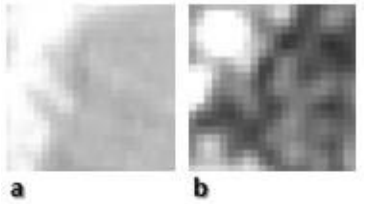
Figure 6. A sample image pair used for training and test (a) NDVI (Optical) (b) SAR.